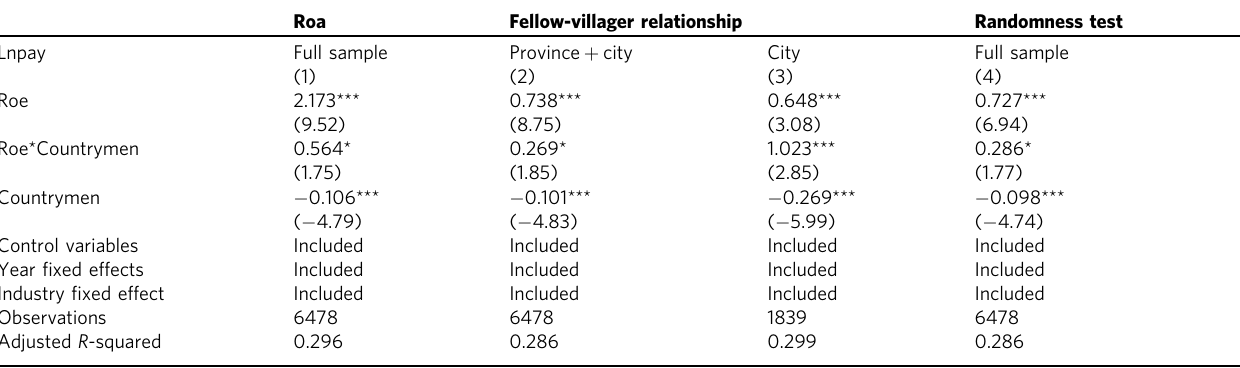
Table 10 Robustness